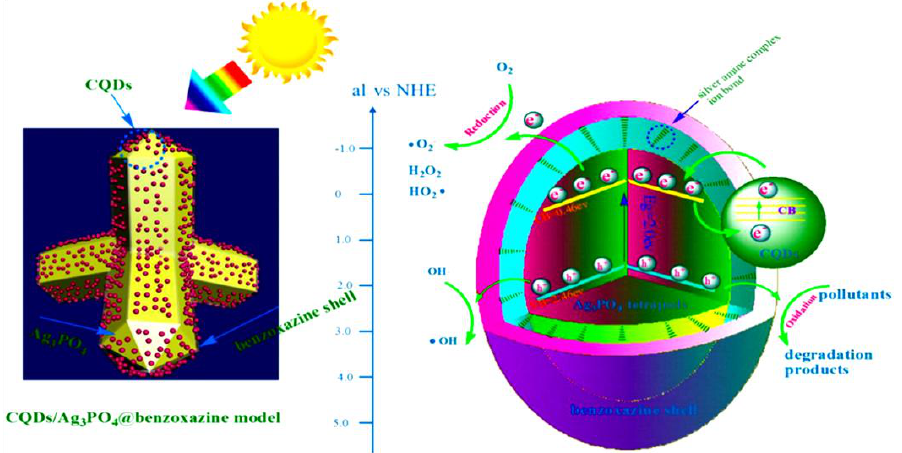
Figure 14. Schematic illustration of the energy band structure and charge transfer mechanism of 3D CQDs/Ag 3 PO 4 @benzoxazine composites [113].